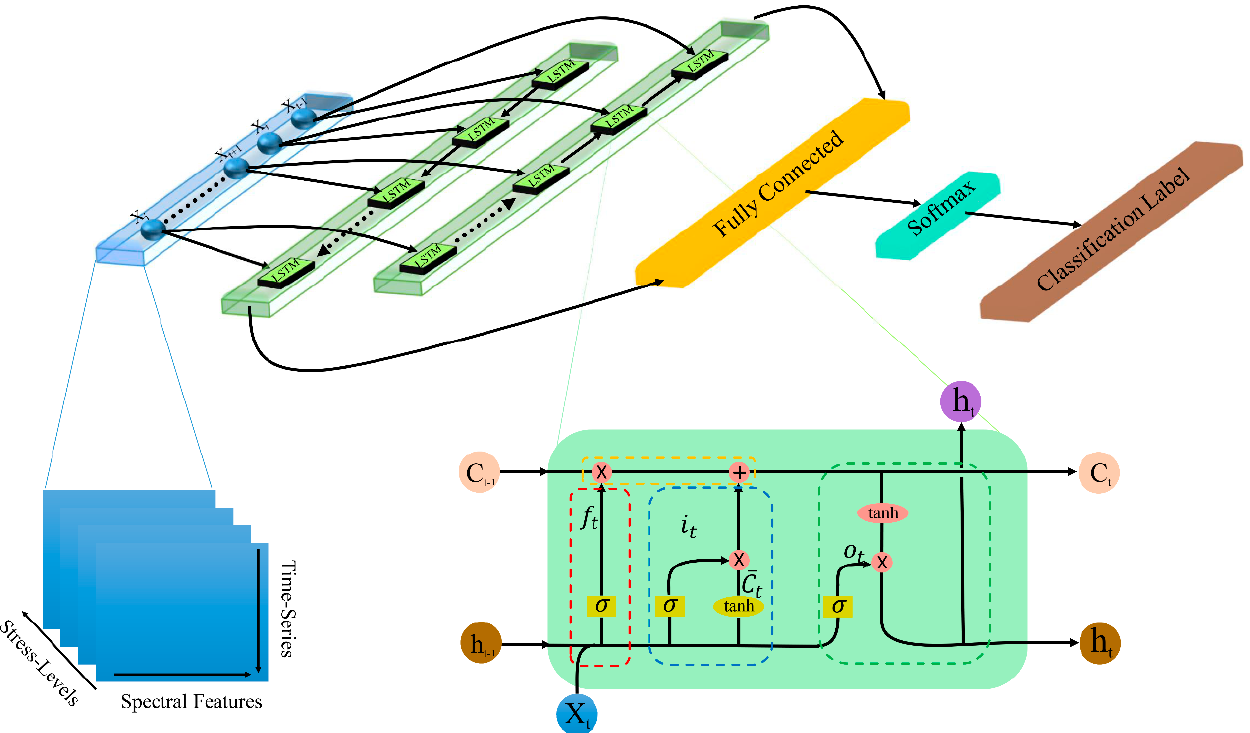
Figure 3. SF-LSTM network structure diagram.